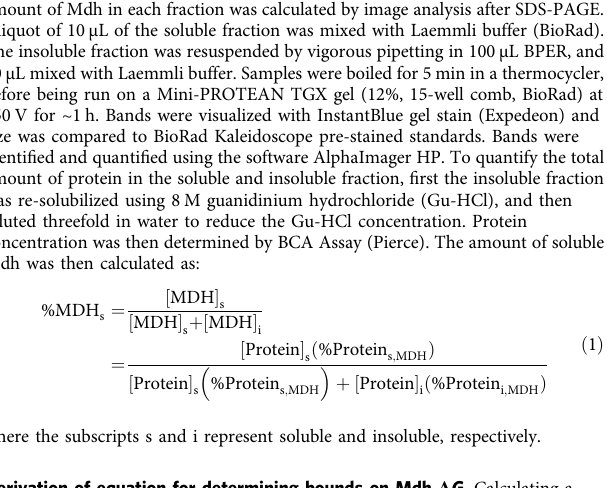
Table 4. E. coli DNA fragments were ampli fi ed using Q5 Polymerase (NEB) and 0.5 μ L culture as a template in a 30 μ L reaction. Gene deletions ( frmA , talB , and zwf ) were